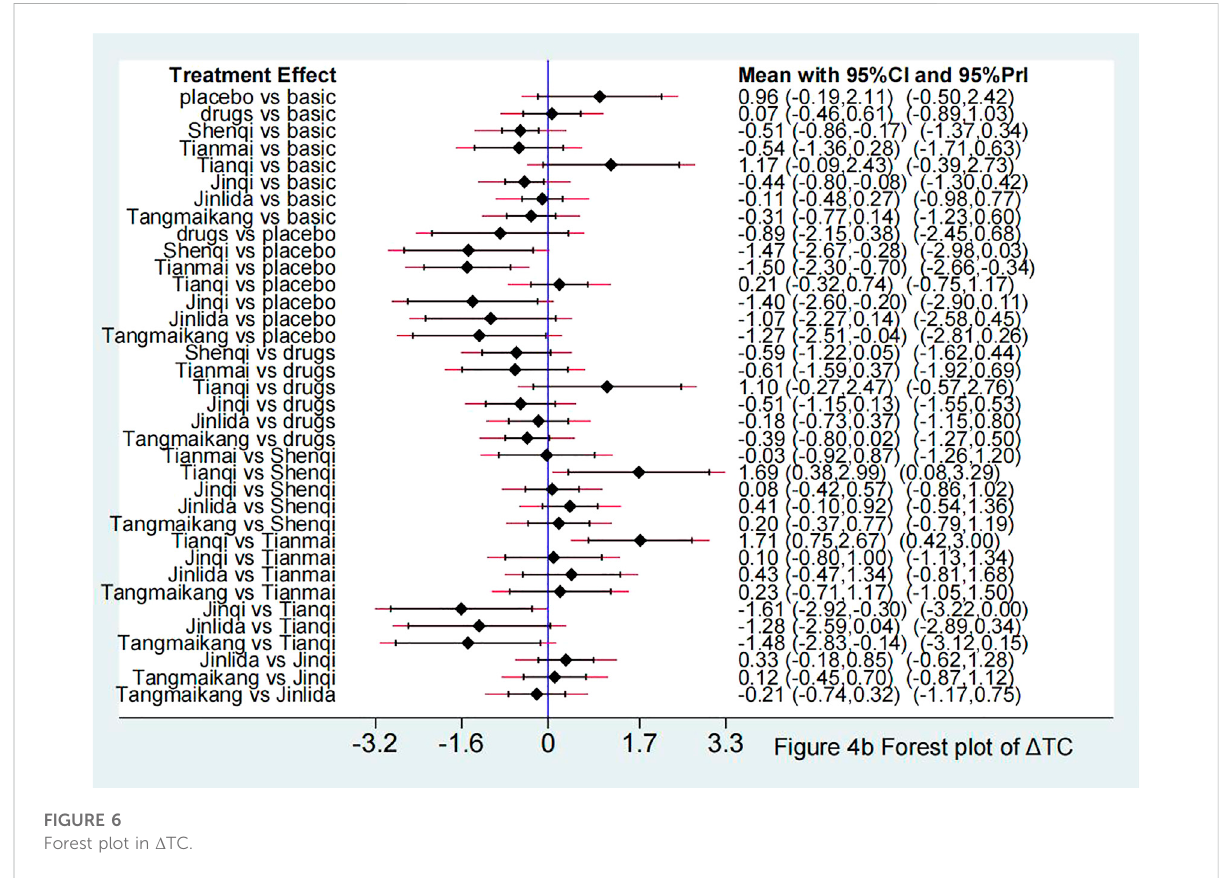
FIGURE 6 Forest plot in Δ TC.